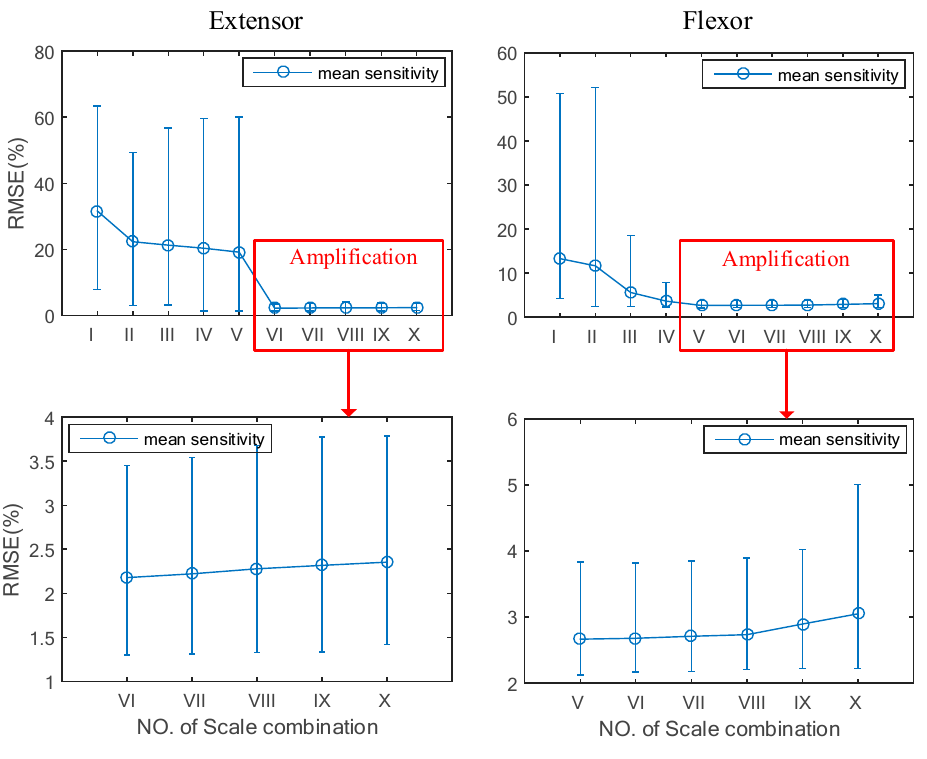
Figure 8. Comparison of the ten WSCs.